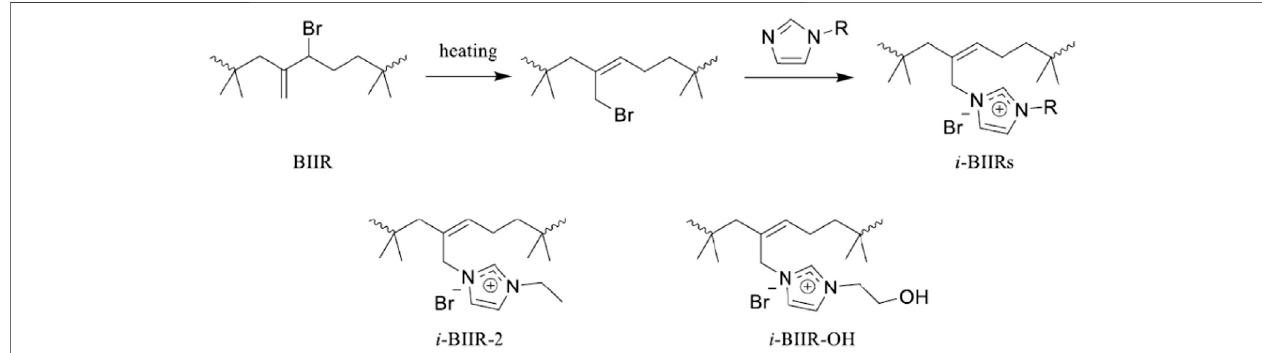
FIGURE 1 | Schematic diagram of the ionization reaction of BIIR and the structure of the